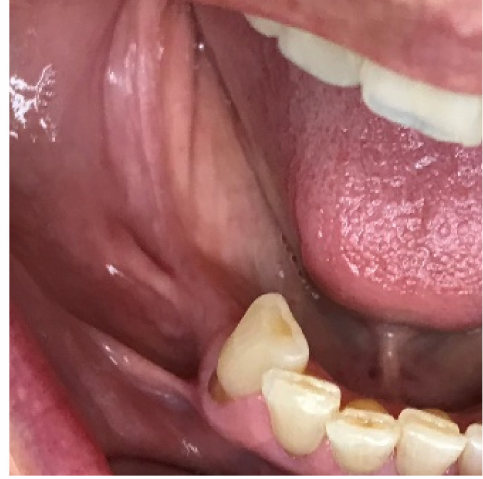
Figure 1. Clinical situation: bone deficiency in the right posterior mandible.